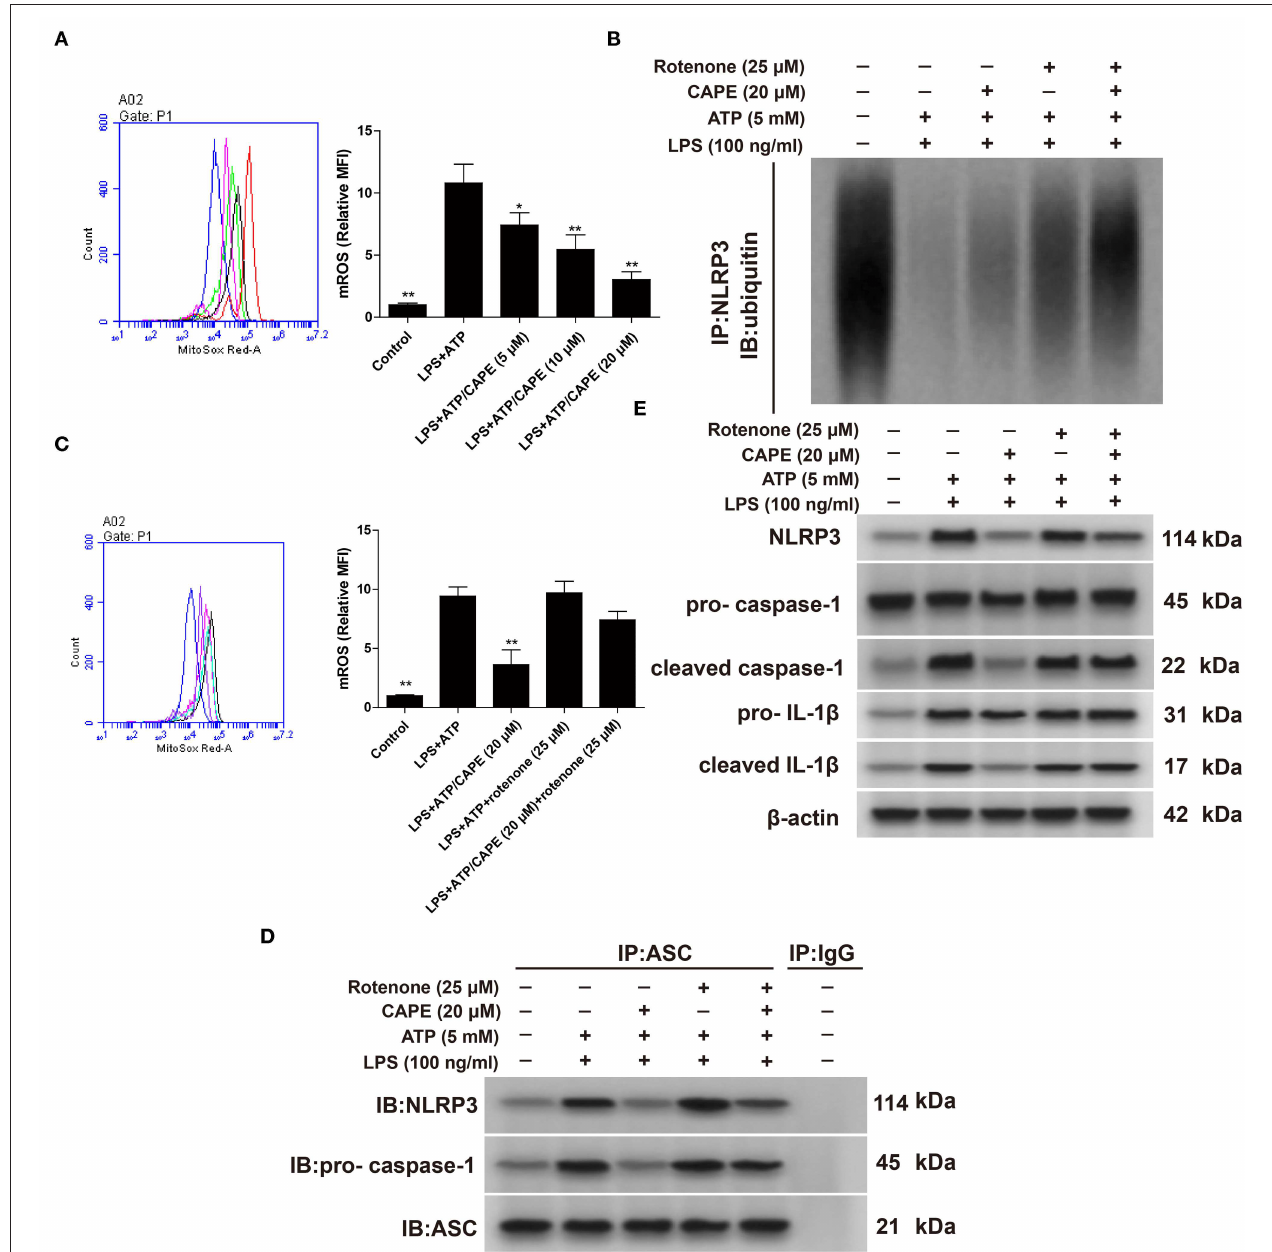
FIGURE 3 | CAPE promotes NLRP3 ubiquitination by inhibiting ROS in THP-1 cells. (A,C) Effect of CAPE on mitochondrial production of ROS. (B) Cell extracts from indicated groups were subjected to immunoprecipitation assays with an anti-NLRP3 antibody, followed by Western blotting with an anti-ubiquitin antibody. (D) Cell lysates were subjected to immunoprecipitation assays with an anti-ASC antibody, using mouse IgG as control. (E) Effect of CAPE on the expression of NLRP3, cleaved caspase-1, pro-caspase-1, cleaved IL-1 β , and pro-IL-1 β in THP-1 cells. Data are presented as mean ± SD ( n = 3). * P < 0.05, ** P < 0.01 vs. LPS + ATP